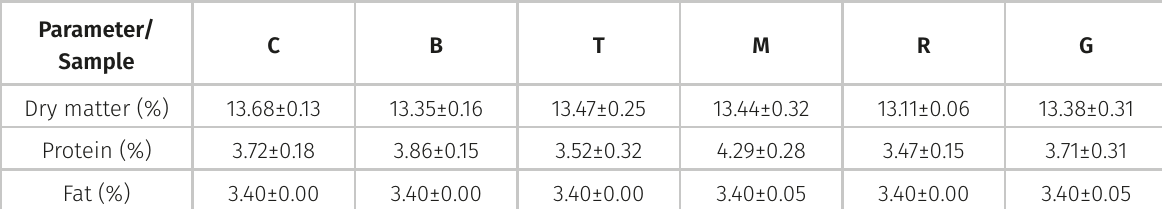
Table I. Physicochemical properties of yogurt samples on the 1 st day of storage period.